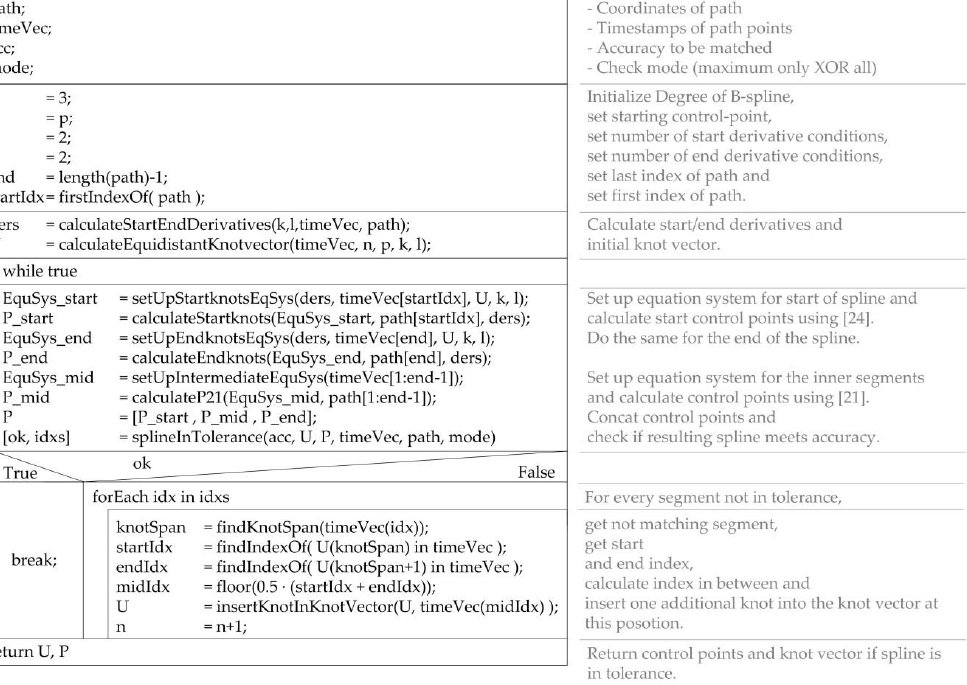
Figure 4. B-spline-based iterative algorithm bsITER, using [21].